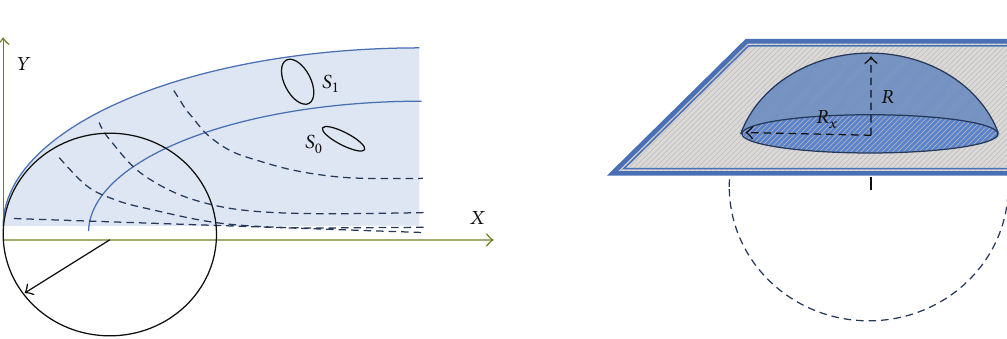
Figure 4: The spherical shape of the droplet used in